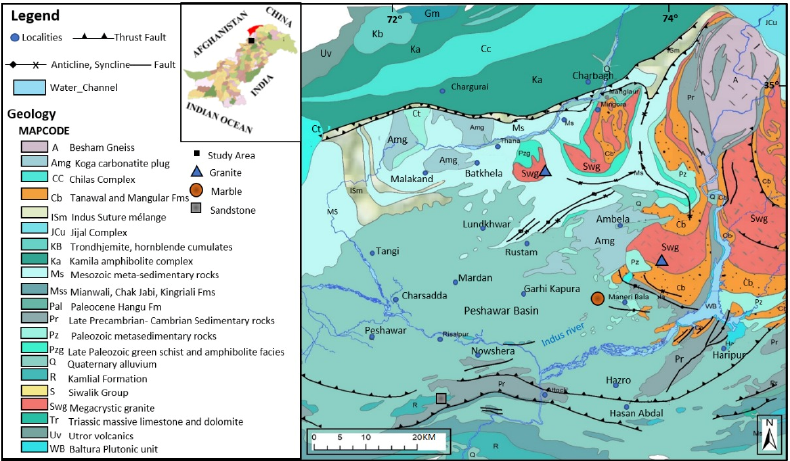
Figure 1. Geological map of the study area showing the locations of the selected